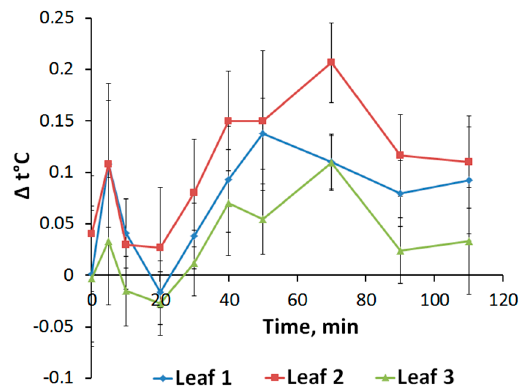
Figure 4. Dynamics of leaf temperature induced by local burning. The moment of stimulation corresponds to the point of 0 min. ∆ t is the temperature difference between the corresponding leaves of stimulated and unstimulated plants.